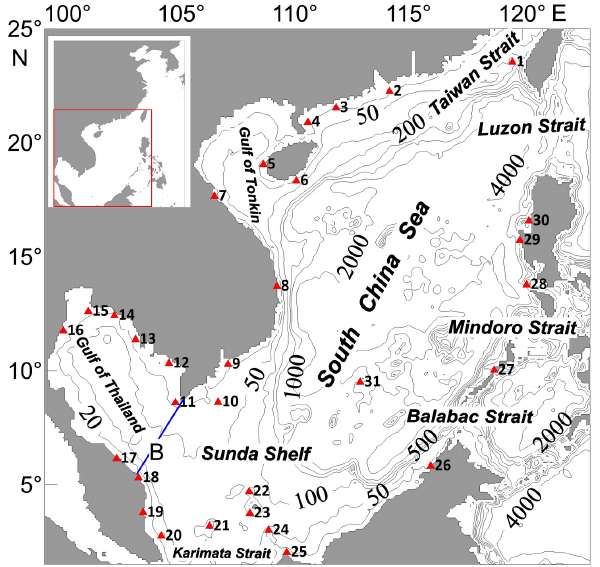
Figure 1. The South China Sea and its neighboring area. The con- tours show the water depth distribution in meters. The blue B line is the mouth cross section of the Gulf of Thailand (GOT). The trian- gles represent the tidal gauge stations (the full names of these sta- tions are given in Table 1). The inset in the upper-left corner shows the entire model domains (99–131 ◦ E, 1.5–42 ◦